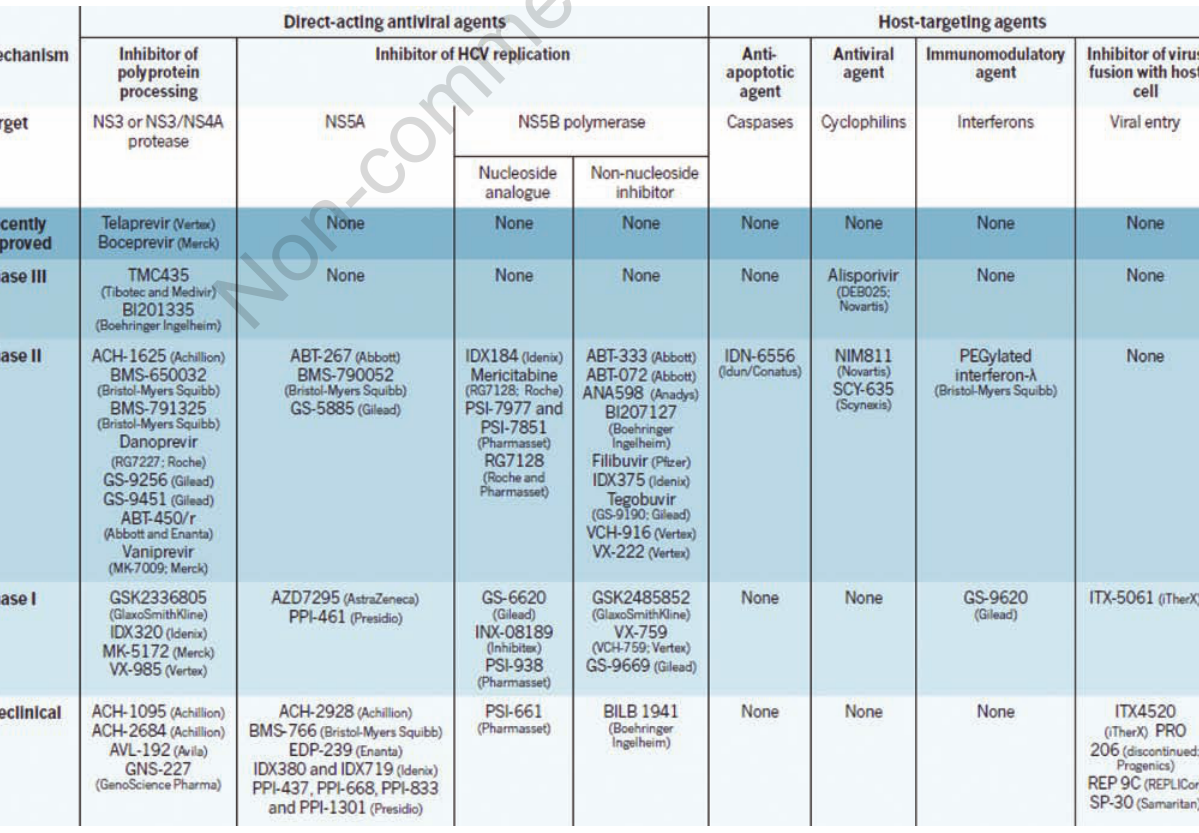
Table 1. Drug candidates for treating HCV infection 2011. (from Nature 2011 New drugs hit the target. Vol